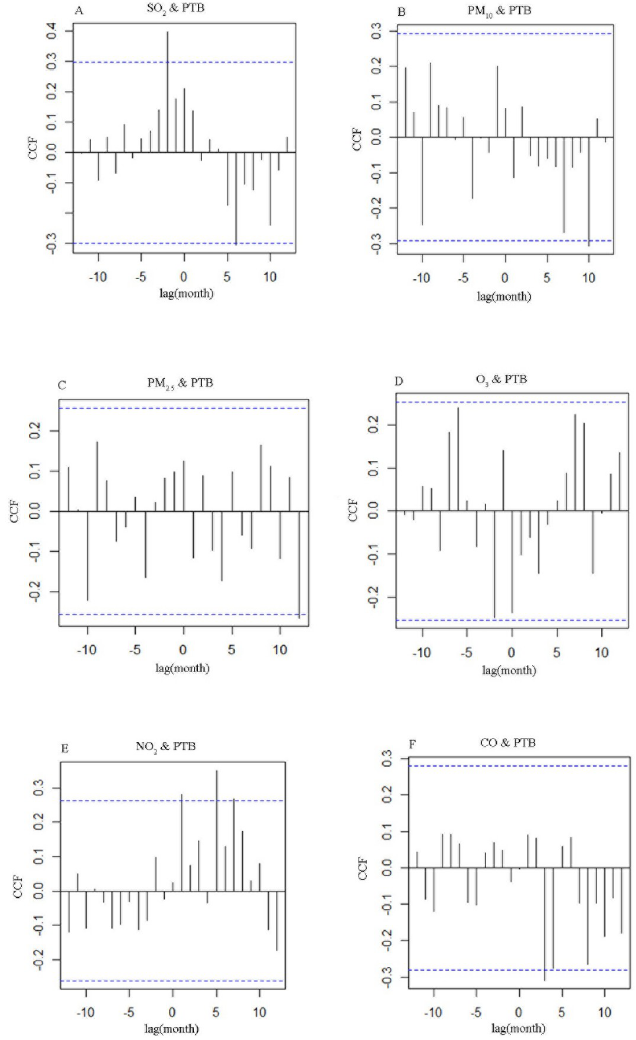
Fig 4. Cross-correlations between the pre-whitened PTB cases and air pollutants.